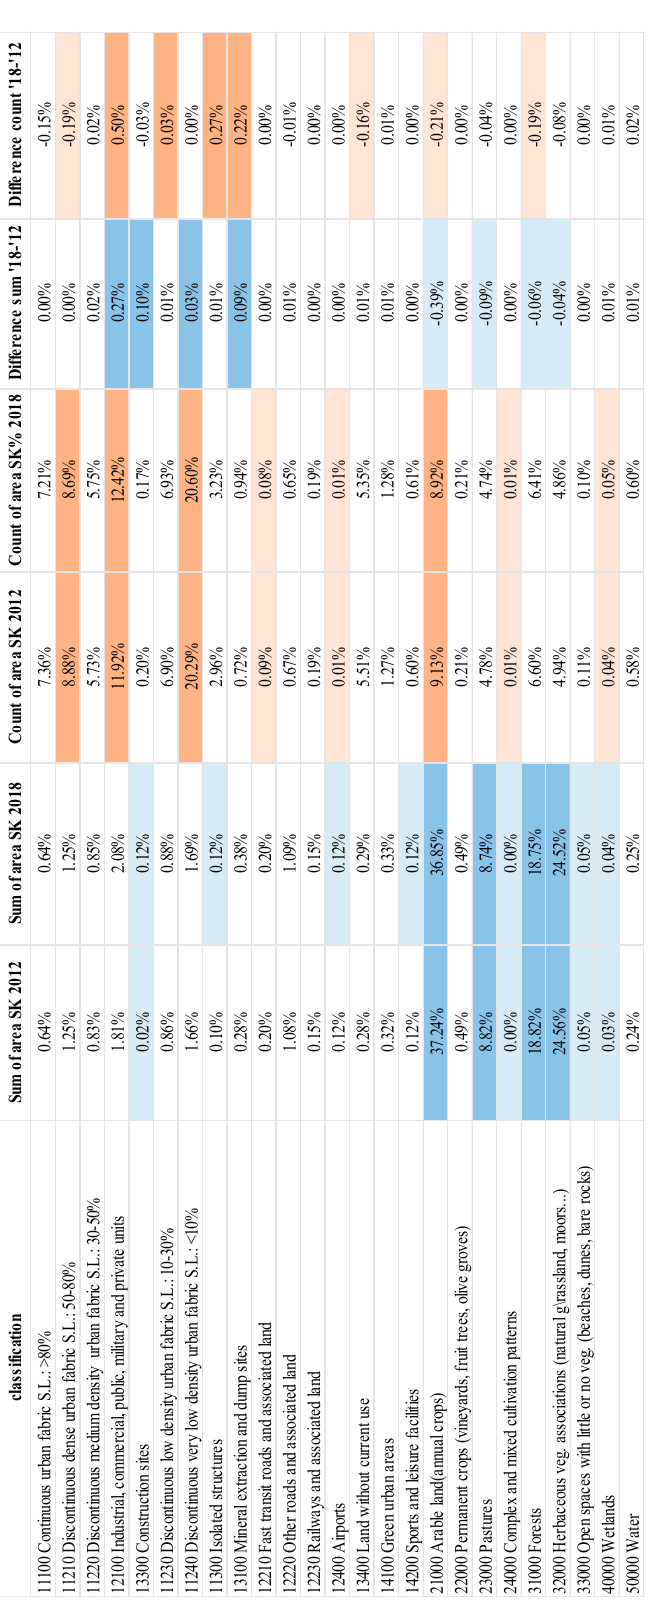
Figure A2. Total area and count of patches of Skopje for 2012–2018 and differences, showing the four highest and four lowest values.